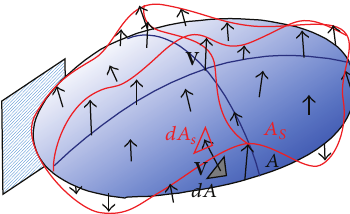
Figure 2: Shape variation of the thin-walled structure by V